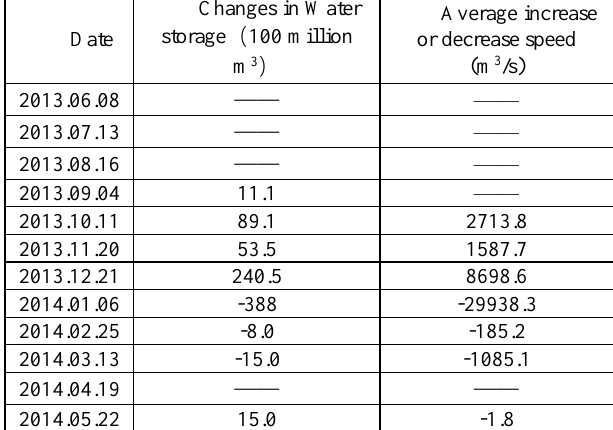
Table 2. Change of water storage of the Tonle Sap Lake